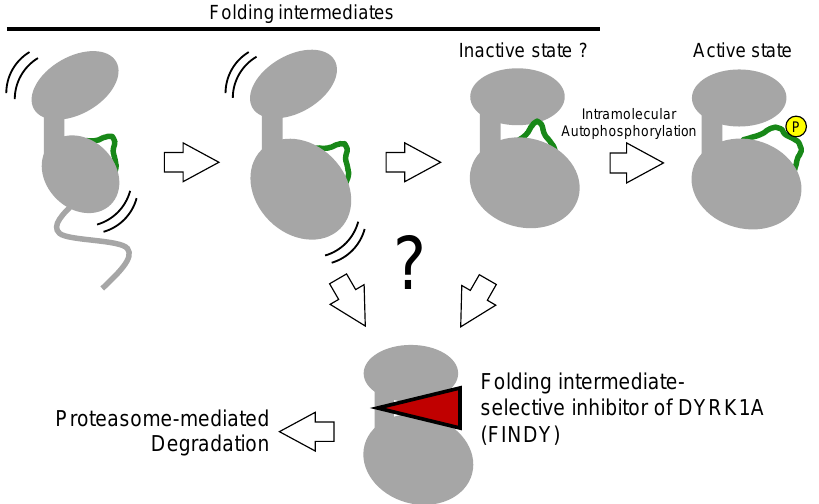
Figure 6. Graphical representation of the folding intermediate selective inhibition of the protein kinase DYRK1A by FINDY. FINDY selectively binds to the folding intermediate and inhibits the progression of the folding process, resulting in proteasome-mediated degradation in the cytoplasm. DYRK1A autophosphorylation has been demonstrated to be a one-off inceptive event required for activation [62,63]. Once the folding process is completed, DYRK1A cannot re-autophosphorylate. On the other hand, FINDY does not inhibit the fully folded form of DYRK1A, which corresponds to the active state. The intermediate state targeted by FINDY has not been clarified.